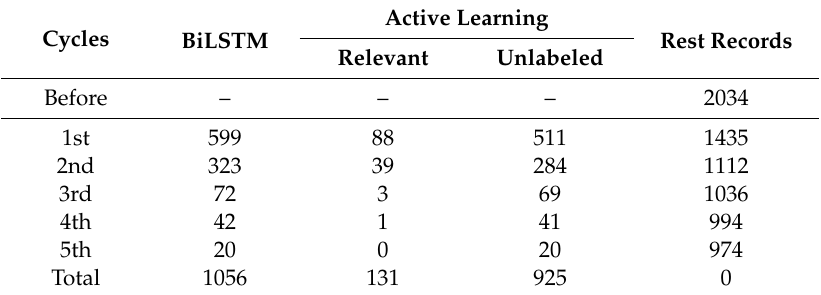
Table 3. Relevant and unlabeled records derived from BiLSTM-based active